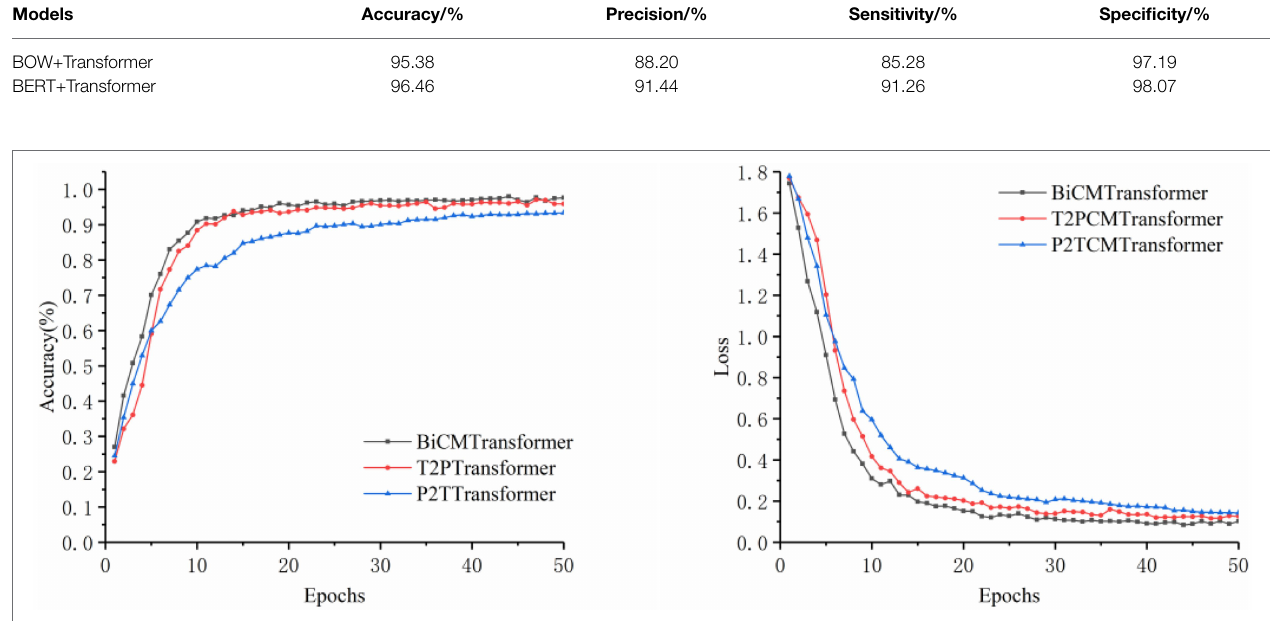
FIGURE 6 | Comparison of accuracy and loss for cross-modal training.